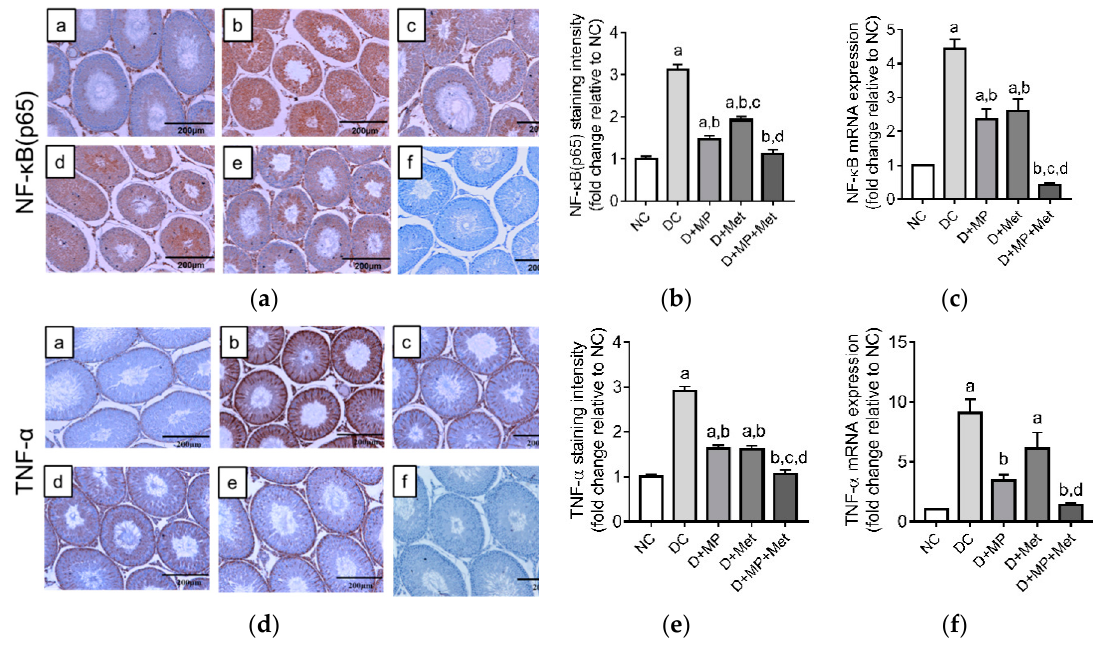
Figure 5. Expression of NF- κ B (p65) protein ( a , b ) and mRNA ( c ); and the expression of TNF- α protein ( d , e ) and mRNA ( f ) in the testes of ( a ) NC, ( b ) DC, ( c ) D + MP, ( d ) D + Met and ( e ) D + MP + Met groups. For each biological replicate, a negative control was included, in which phosphate bu ff ered saline was substituted for the primary antibody. A representative photomicrograph of the negative control is shown as ( f ) (magnification = × 100, scale bar = 200 µ m). For quantitative data, values are mean ± SD, n = 8 (for staining intensity) and n = 6 (for mRNA expression). a p < 0.05 versus